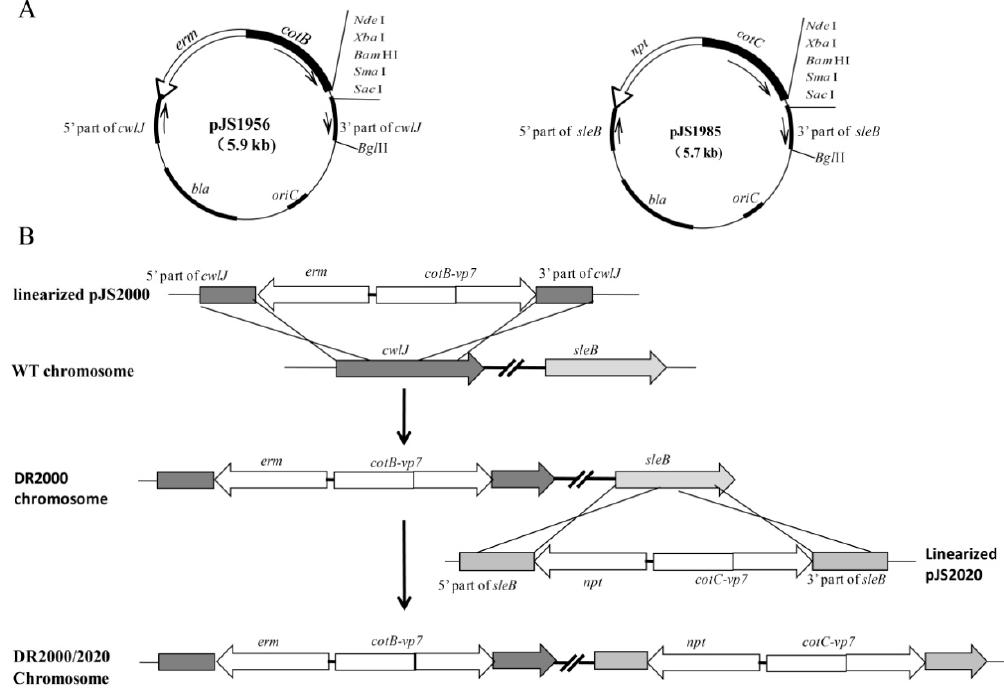
Figure 1. Schematic diagram showing the construction of the recombinant B. subtilis strains. ( A ) The genetic structure of the integrative platform vectors pJS1956 and pJS1985. ( B ) The flow chart for the construction of the strain DR2000/2020.